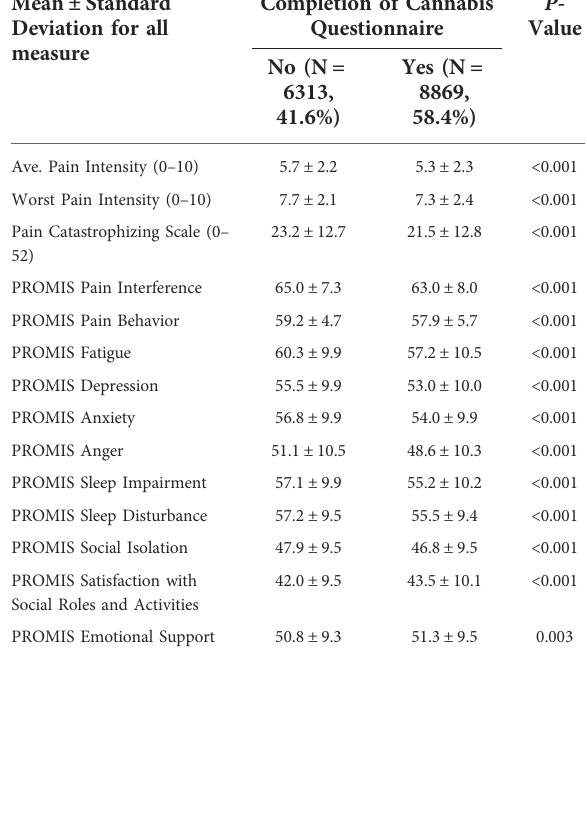
TABLE A1 Baseline demographics based on completion of cannabis questionnaire.